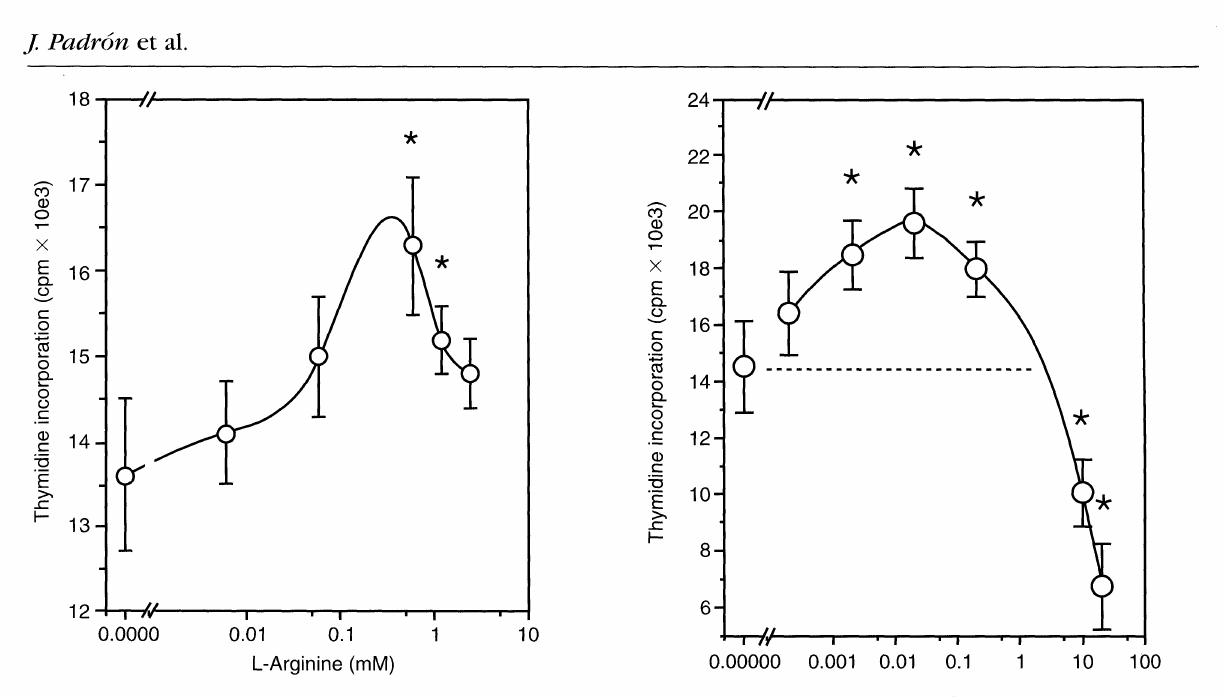
FIG. 3. Concentration-dependent modulatory effect of L- arginine upon the proliferation induced by IL2 (5 U/ml) on CTLL-2 cells. Each point is the mean -t-SEM of three experiments. Student’s t-test was assessed vs baseline. Significant difference was accepted for * p < 0.05.